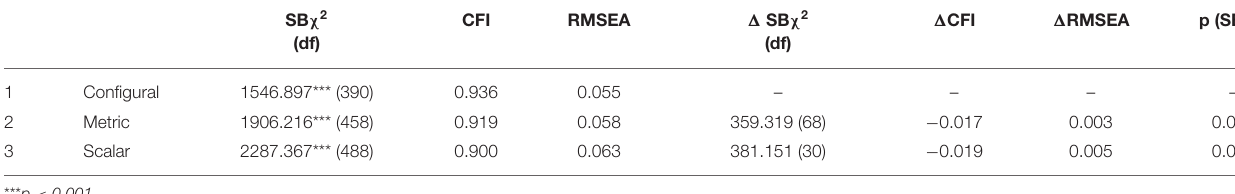
TABLE 3 | Multigroup confirmatory factor analysis of the bifactor model of SWB.